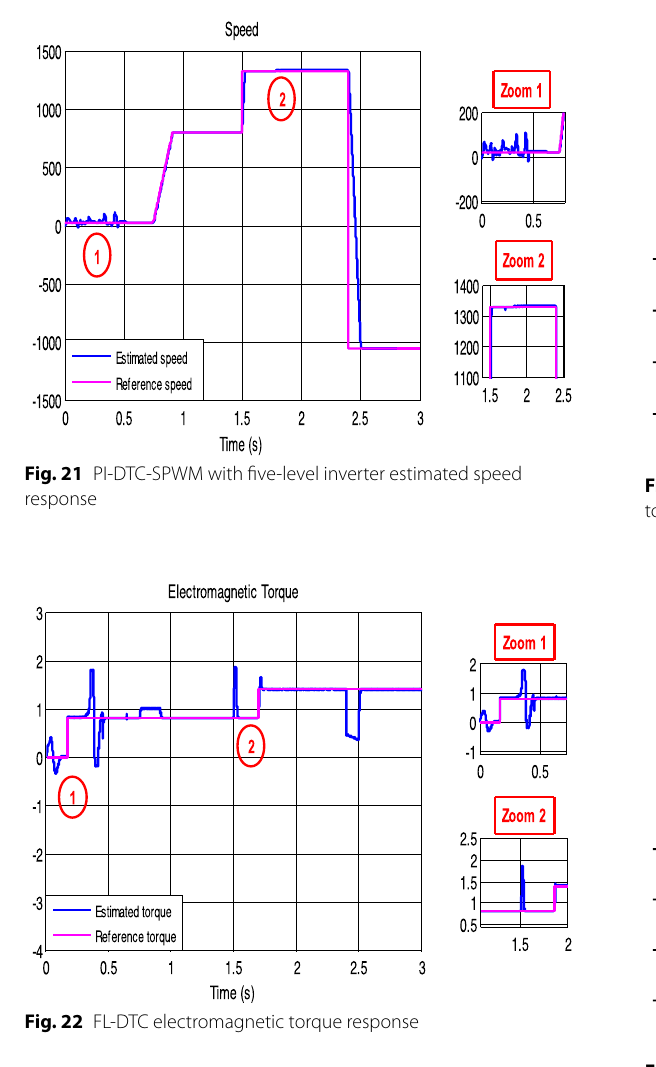
Fig. 24 PI-DTC-SPWM with five-level inverter electromagnetic torque